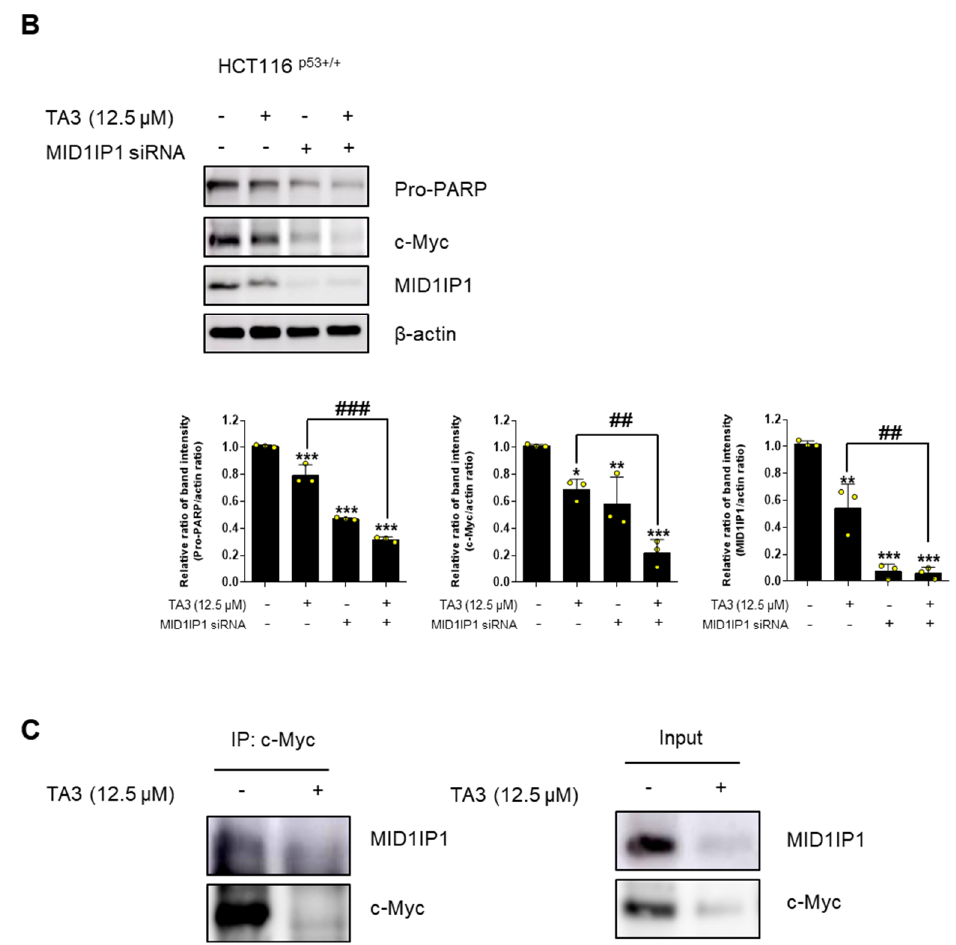
Figure 5. TA3 inhibits c-Myc and induces apoptosis via CNOT2 or MID1IP1. ( A ) HCT116 p53+/+ cells were transfected with CNOT2 siRNA or control siRNA for 48 h and then cells were treated with TA3 (12.5 μM) for 24 h (three independent experiments in HCT116 p53+/+ cells). ( B ) HCT116 p53+/+ cells were transfected with MID1IP1 siRNA or control siRNA for 48 h and then cells were treated with TA3 for 24 h (three independent experiments in HCT116 p53+/+ cells). Statistical significance was analyzed using one-way analysis of variance (ANOVA) followed by Tukey’s test and the unpaired t-test. p -value indicates a significant difference between the groups. Quantification of protein expres- sion is shown in the lower panel. * p < 0.01, ** p < 0.005, *** p < 0.001 vs. control; # p < 0.01, ## p < 0.005, ### p < 0.001 vs. only TA3-treated group. ( C ) HCT116 p53+/+ cells were treated with TA3 for 24 h. Then, cells were harvested for co-immunoprecipitation assay.